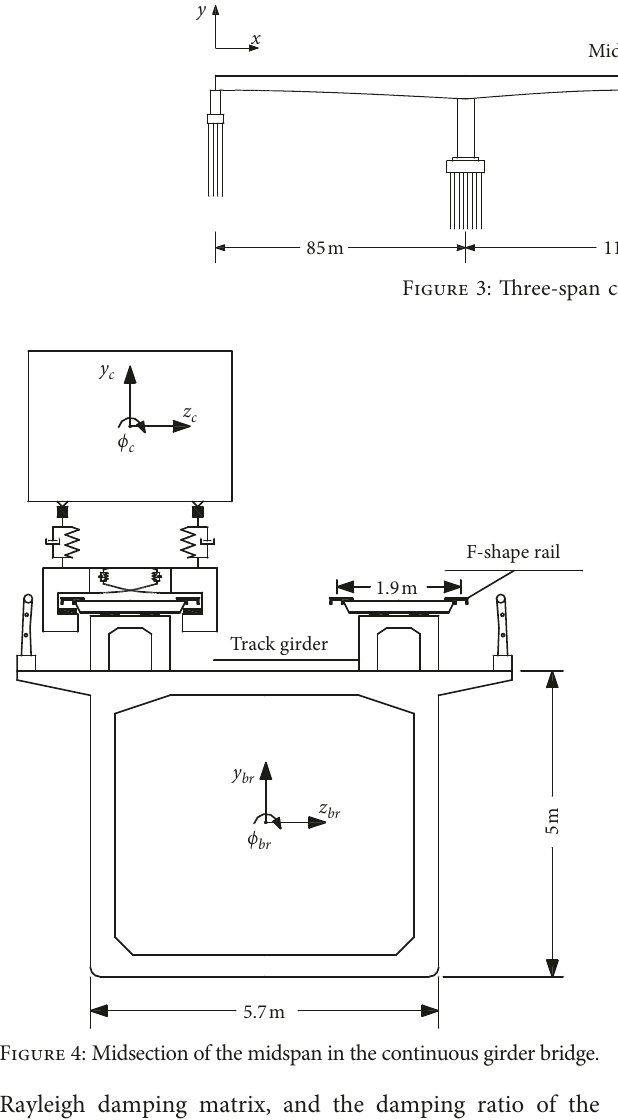
Figure 4: Midsection of the midspan in the continuous girder